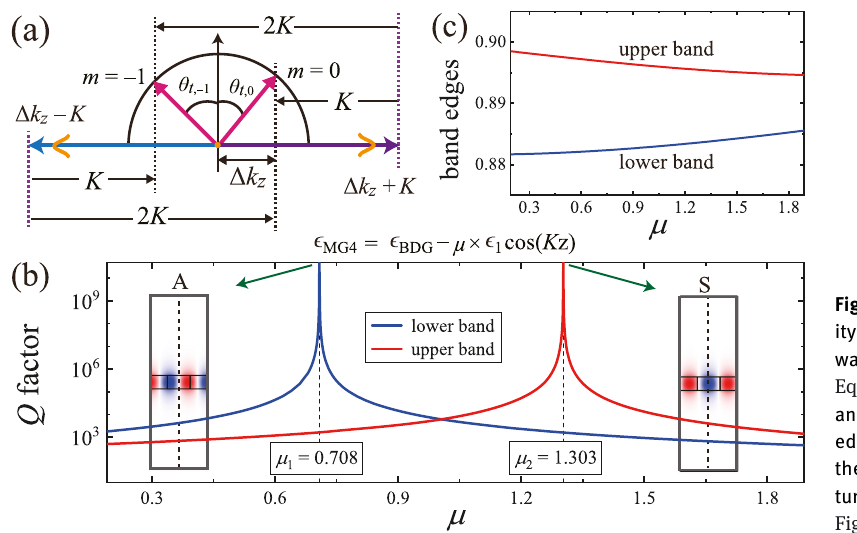
Figure 5: Resonant diffraction in the vicin- ity of the third stopband beyond the sub- wavelength limit. (a) Diffraction orders by Eq. (5) . Simulated (b) radiative Q factors and (c) eigenfrequencies of the two band- edge modes as a function 𝜇 . In addition to the engineered dielectric function, the struc- tural parameters were the same as those in Figure 2 .